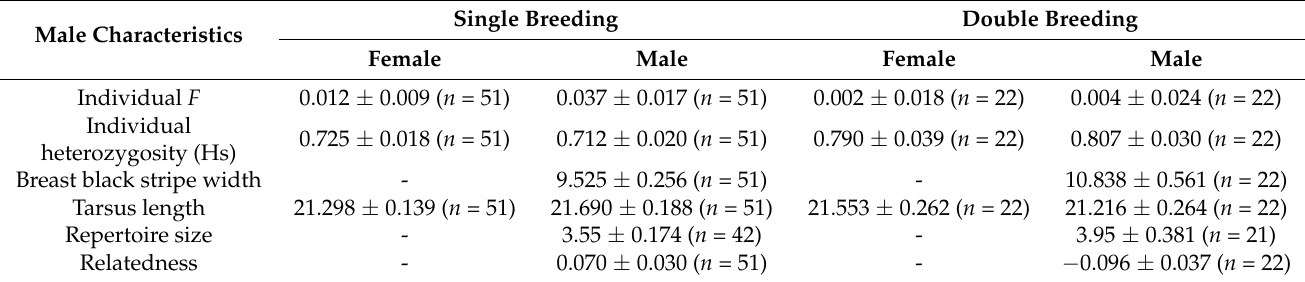
Table 1. Basic statistics (mean ± S.E. and range) for the different female and male characteristics analyzed in the present study.